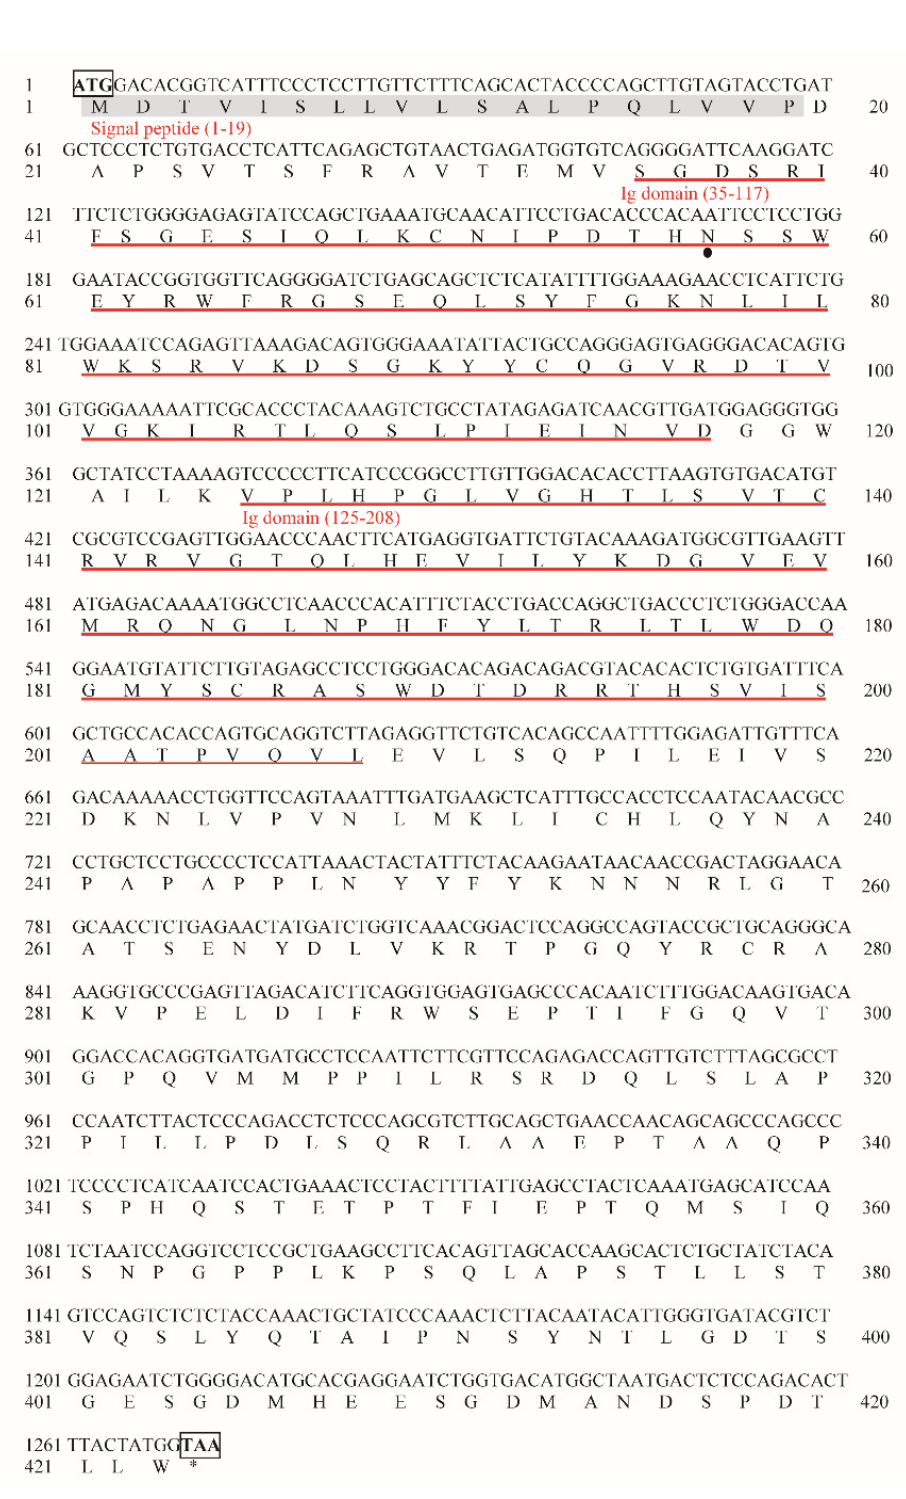
Figure 1. Nucleotide and deduced amino acid sequence of MsFc γ RI α (GenBank accession No. OK258092). The predicted signal peptide domain is shaded in gray, and two Ig domains are indicated with red underlines. The solid black dot highlights a potential N-linked glycosylation site. The start codon (ATG) and stop codon (TAA) are marked with black boxes, and the stop codon was also illustrated as